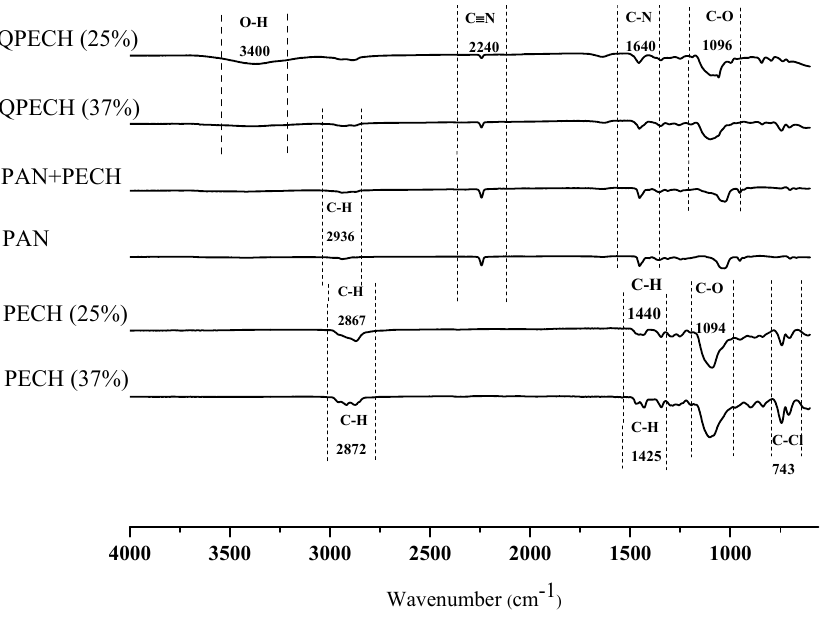
Figure 5. FTIR spectra of the polymers.